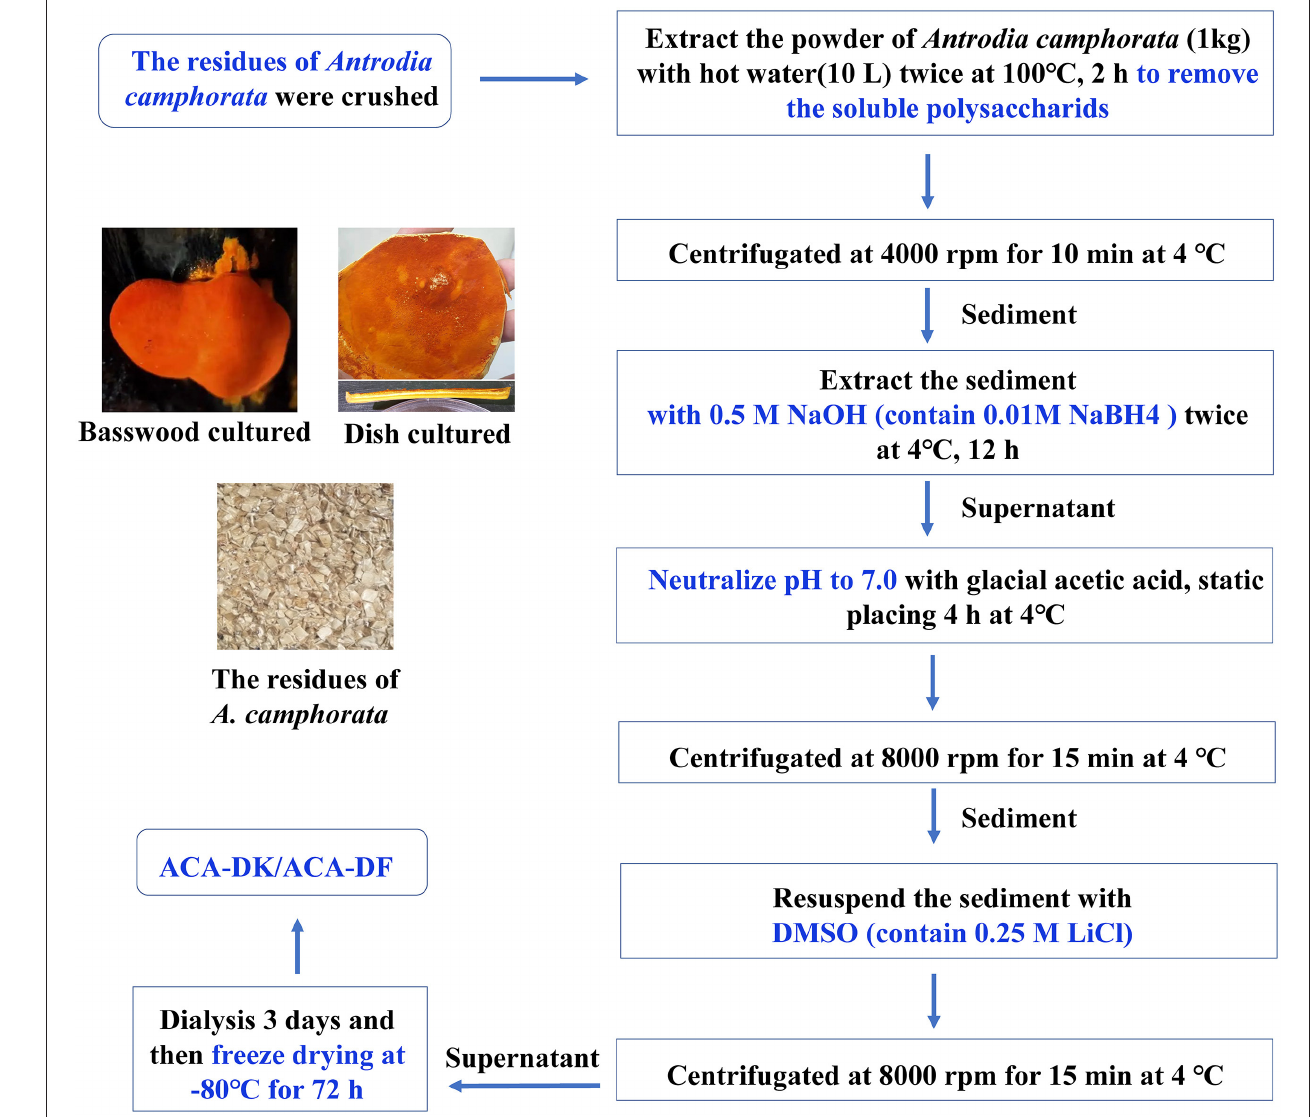
FIGURE 1 | Flow chart representative of the extraction processes of dietary fibers ACA-DK and ACA-DF from the residues of A. camphorata .